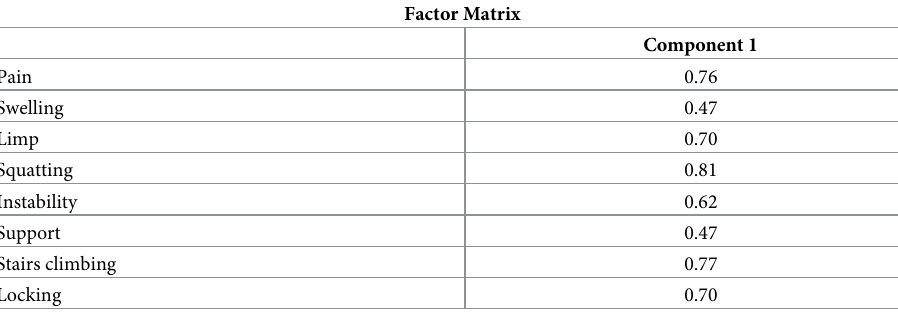
Table 2. Factor loading items for the one-factor